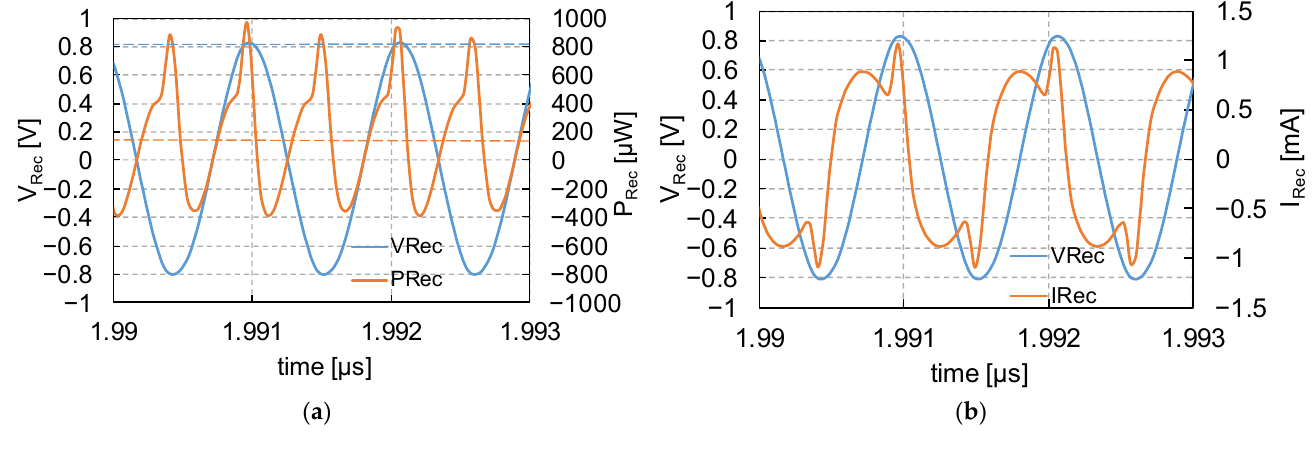
Figure 6. Waveforms of V Rec and P Rec ( a ) and of V Rec and I Rec ( b ). A value of R R is determined by the effective voltage V Rec − RMS and the average power P Rec , as shown in Equation